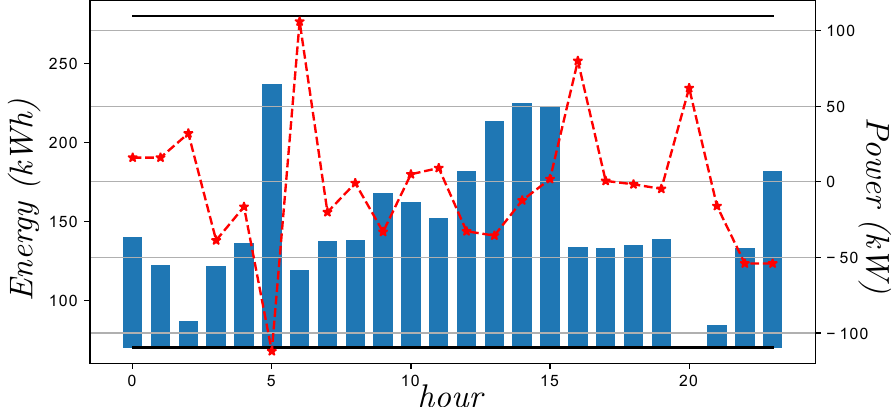
Figure 11. Battery management for Case Study 2 where the bars are the SOC at every time instant and the red dashed line is the power given or required by the battery.